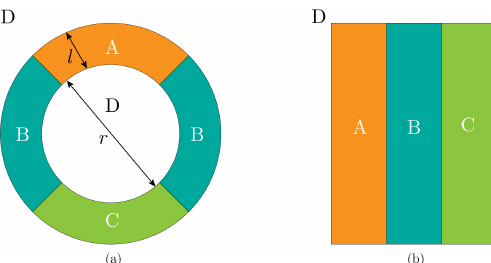
Figure 2: ( a ) The graph configuration to define the topological entropy, i.e. I ( A ; C | B ) . l is the feature size of this graph configuration and l ∼ O ( N ) , where N 2 is the total number of qudits, while r ∼ O ( N ) is radius of this topologically non trivial domain. Here and throughout the paper we assume r > l . ( b ) I ( A ; C | B ) = 0 in this simple graph configuration, even though there is long-range entanglement of the ground